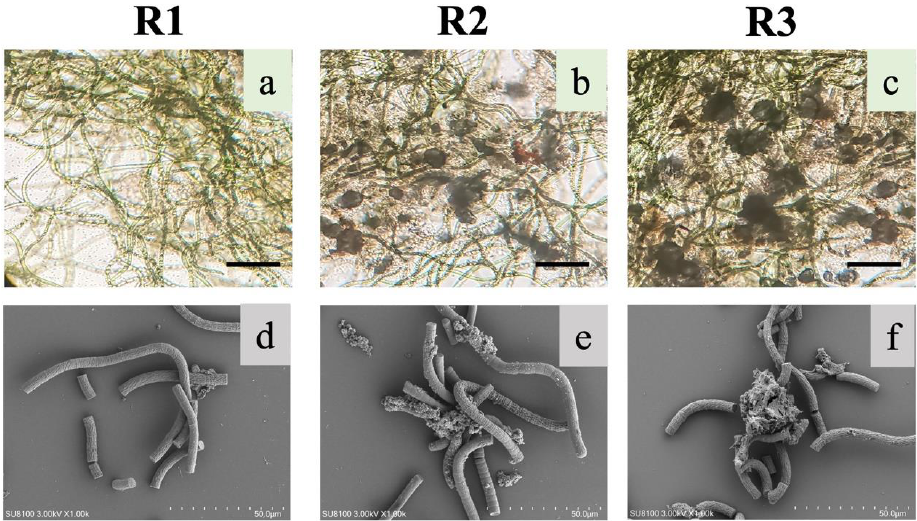
Figure 2. Images of suspension S. platensis and microalgal aggregates in bioreactor R1, R2, and R3 obtained with light microscope ( a – c ) or SEM ( d – f ). Scale bar for panels is ( a – c ) 100 μm (solid lines) and ( d – f ) 50 μm (dotted lines).